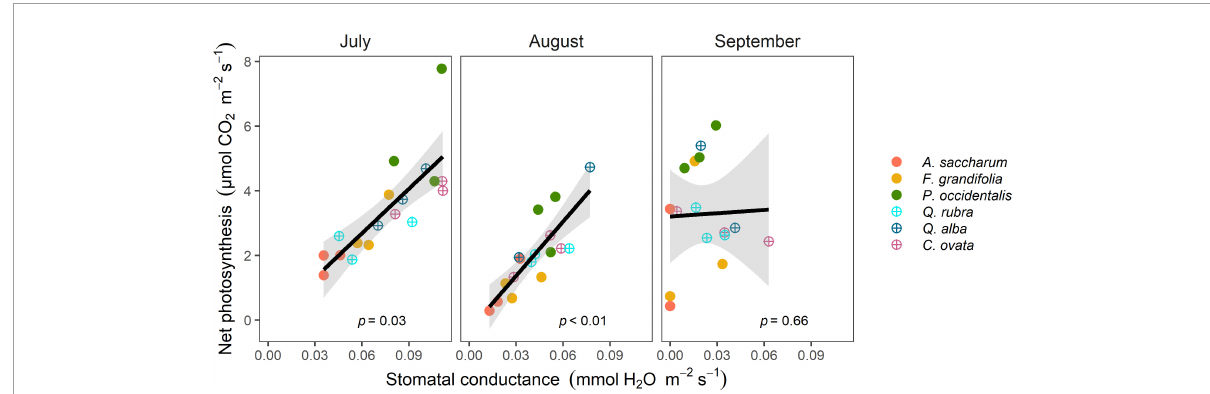
FIGURE2 Net photosynthesis significantly increased with stomatal conductance in all trees during July and August, but the relationship decoupled by September. Different colors represent different species and different shapes represent diverse wood types; solid circles are diffuse-porous species and opened circles are ring-porous species. Each data point represents the mean of three individual trees. The model fit line is based on a 95% confidence interval (shaded in gray).